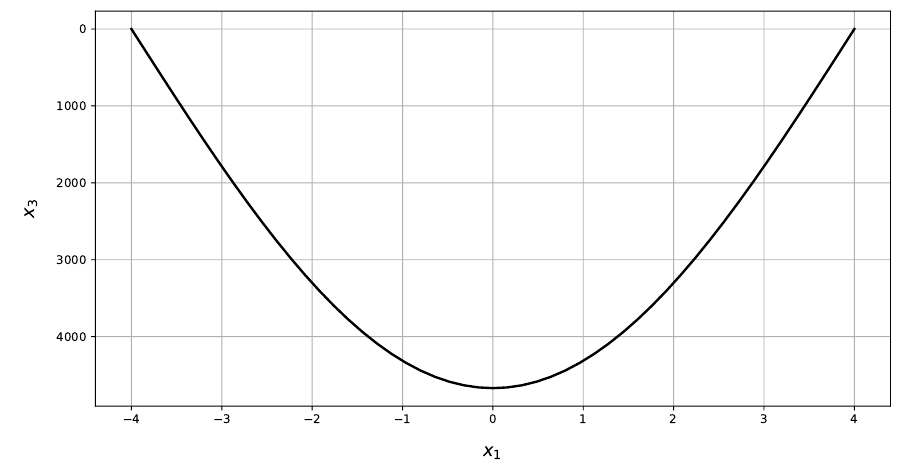
Figure 17. The bending moments M 11 in section x 2 = 0 of a simply supported rectangular